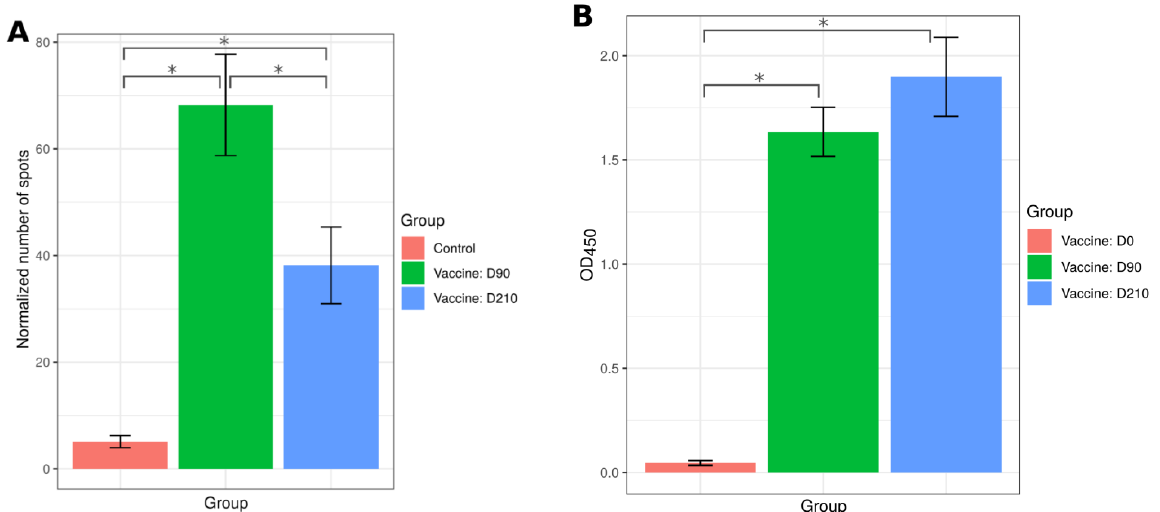
Figure 6. Analysis of the T cell and humoral immune response at day 90 (D90) and day 210 (D210) after SputnikV vaccination. ( A ) T cell immune response. PBMCs from 26 vaccinated (D90 and D210) and 12 SARS-CoV-2 antibody-negative controls were used to analyze T cell immune response using the Tigra test SARS-CoV-2 kit (Generium Corporation, Vladimir region, Russia). Spots were counted, the background (spots in unstimulated PBMCs) was subtracted, and results were presented as a normalized number of spots. ( B ) Forty serum samples were collected at day 0 (D0), day 90 (D90) and day 210 (D210) of SputnikV vaccination. Anti-SARS-CoV-2 IgM, IgG and IgA antibodies were detected using the Coronapass ELISA kit (BioPalitra, NextGene Russia). Data are presented as Mean ± SEM (standard error of the mean). Y-axis shows OD450 value (Coronapass ELISA kit; BioPalitra, NextGene Russia) * - statistical significance.